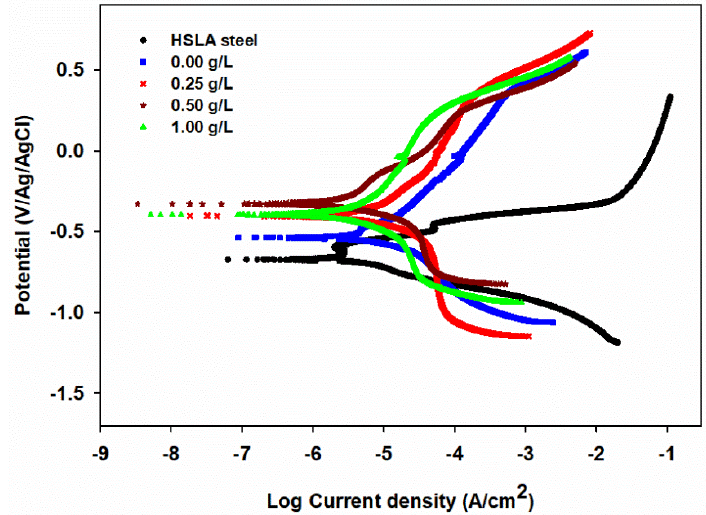
Figure 10. Tafel curves for HSLA steel, NiP, and NiP-TNPs nanocomposite coatings (NiP-0.25TNPs, NiP-0.5TNPs, and NiP-1.0TNPs) immersed in 3.5 wt. % NaCl solution at 25 °C and a scan rate of 0.167 mV·s –1 . Table 6. Tafel fitting results of the HSLA steel, NiP, and NiP-TNPs composite coatings (NiP-0.25TNPs,